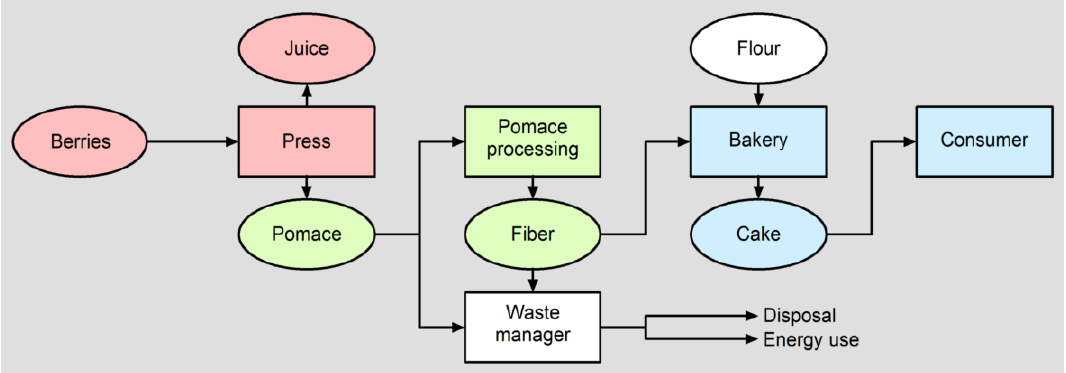
Figure 2. Flow chart for berry pomace incorporation in cereal-based